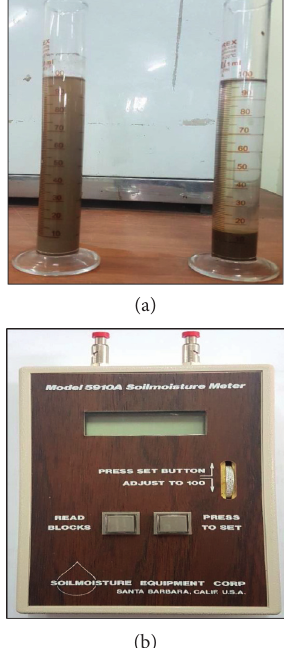
Figure 5: (a) Free swell index arrangement. (b) Moisture meter used for soil